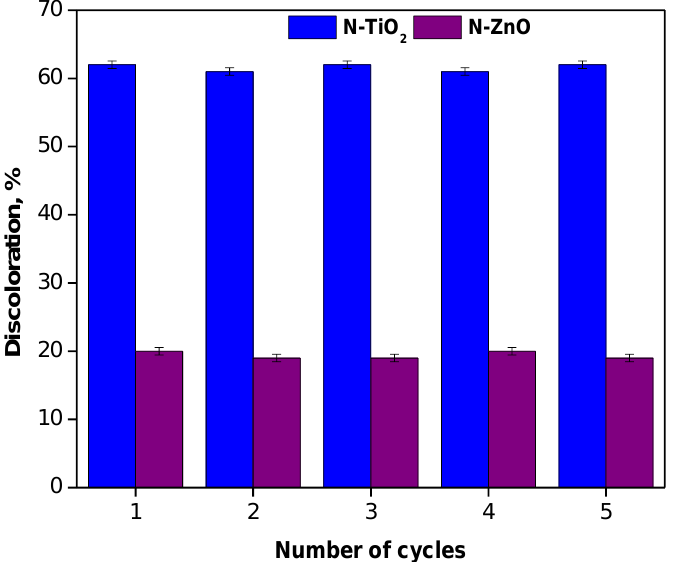
Figure 7. EBT discoloration after 180 min under visible light for five reuse cycles.